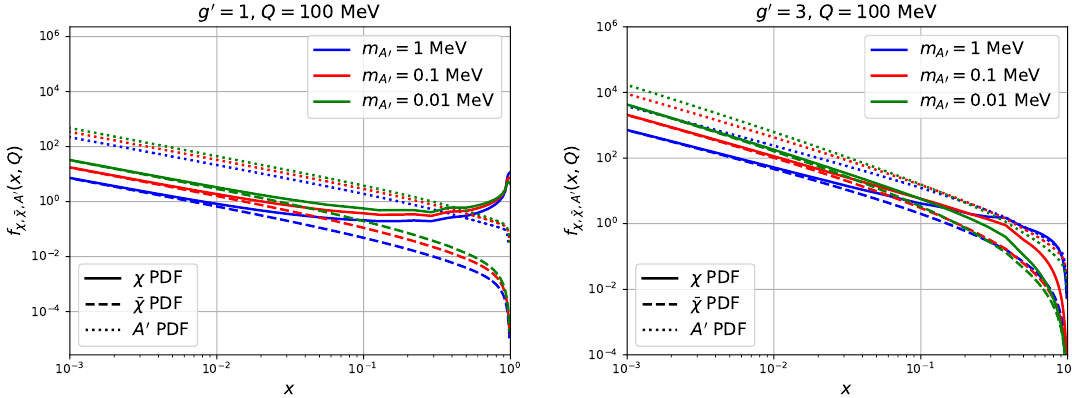
Figure 1 . The PDFs of χ (solid line), ¯ χ (dashed line) and A 0 (dotted line) at factorization scale of 100 MeV. Different colors indicate the dark photon mass as shown in the legend. The coupling g 0 = 1 in left panel and g 0 = 3 in right panel. The dark matter mass is taken to be 0.01